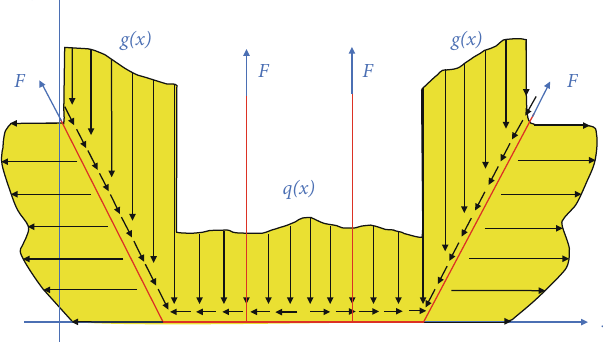
Figure 18: Mechanical model of support structure in stage I.